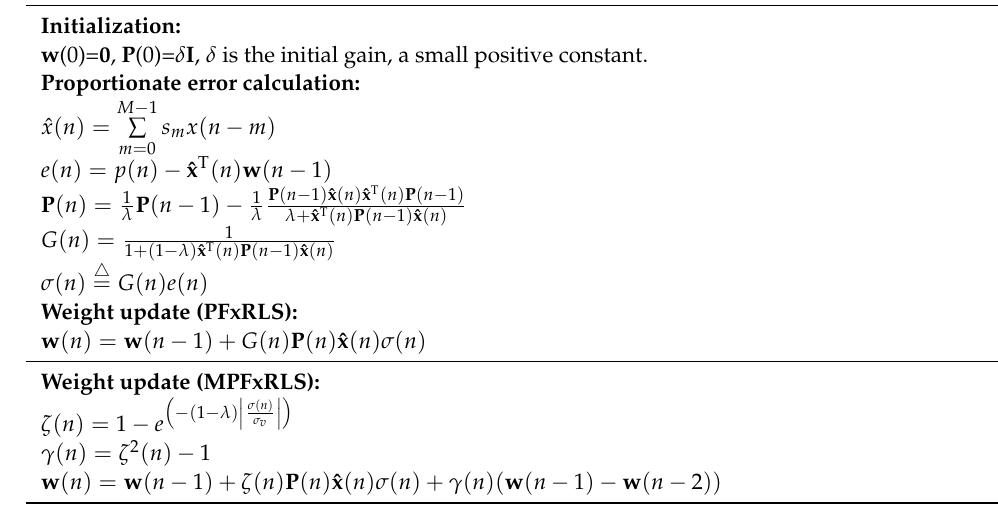
Algorithm 1. The summary of the proposed algorithms.